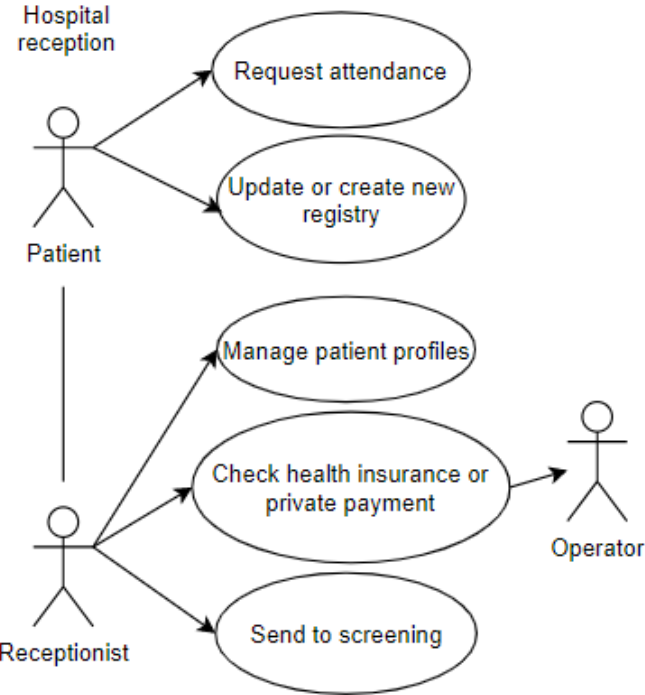
Figure 3. Reception at the Emergency